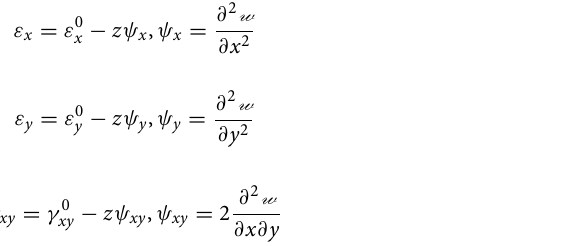
u v = ∂ /∂ y + ∂ /∂ x is the shear strain xy